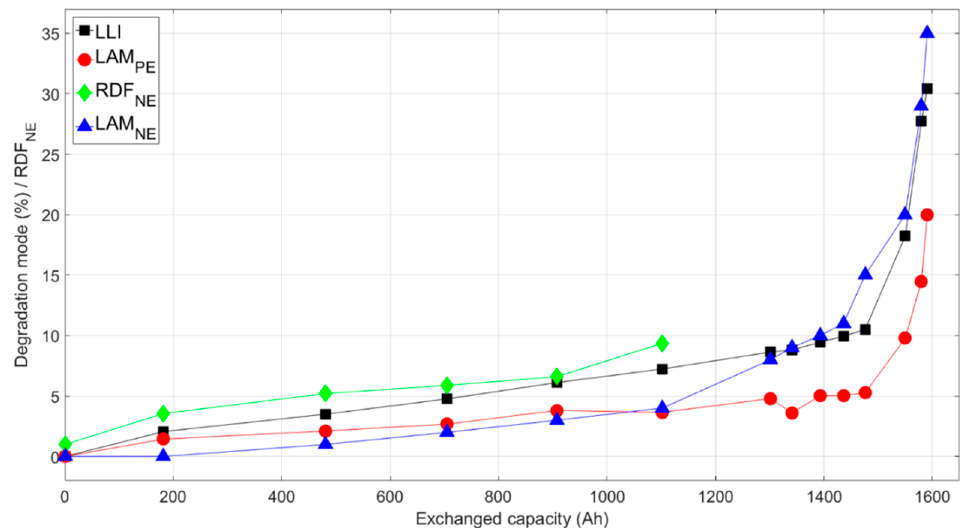
Figure 9. Plot of the calculated degradation modes vs. exchanged capacity for one cell subjected to the DST profile illustrating the representative trends of each.